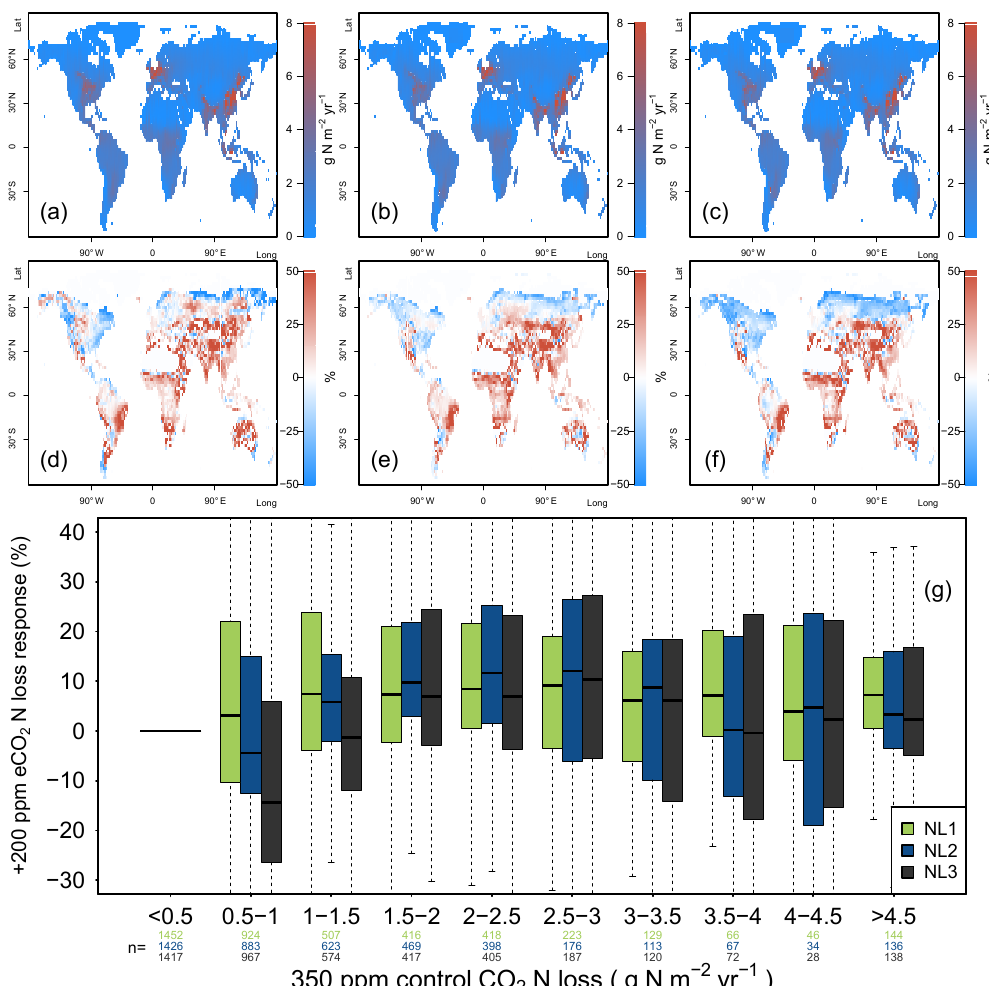
Figure A4. (a, b, c) Global nitrogen (N) loss rates (gNm − 2 yr − 1 ) for the control runs (350ppm atmospheric CO 2 concentration), using the N loss algorithms NL1 (a) , NL2 (b) , and NL3 (c) . (d, e, f) Global N loss responses (%) to elevated atmospheric CO 2 concentrations (eCO 2 , + 200ppm). (g) Global response ratios (%) plotted against the corresponding control N loss rates, binned in intervals of 0.5gNm − 2 yr − 1 . Boxes show median and quartiles; whiskers show the largest/smallest outliers that lie below/above 1.5 times the interquartile range. Further outliers were omitted. Coloured numbers indicate the number of 2 ◦ × 2 ◦ grid cells that fell into the respective N loss range. The 350– 550ppm difference in atmospheric CO 2 concentrations approximately corresponded to the 1988–2052 time span in our global simulations. The difference to Fig. 4 was that these simulations also included transient climate and N deposition rates according to the RCP 8.5